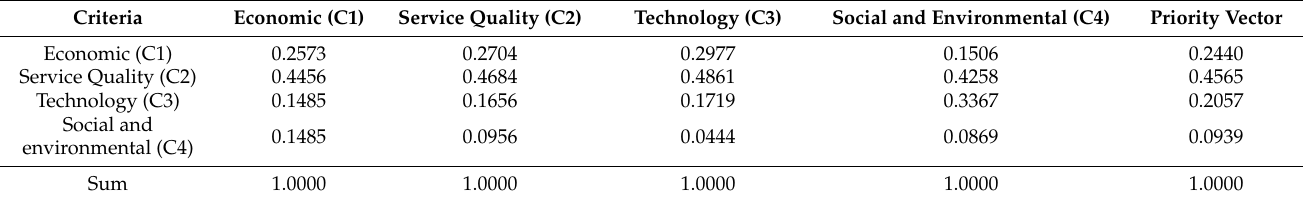
Table 7. The normalized comparison matrix of FAHP